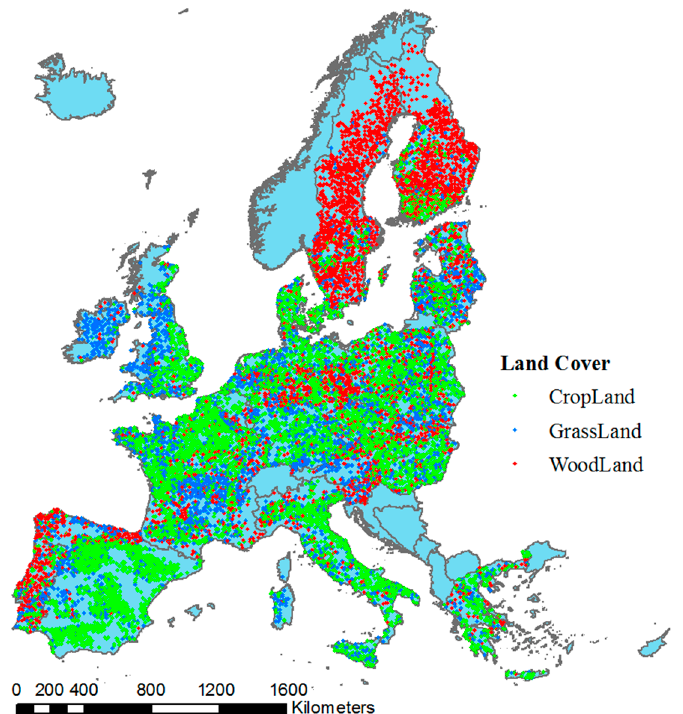
Figure 1. Location of selected soil samples from the Land Use/Land Cover Area Frame Survey (LUCAS) soil spectral library. The colour indicates the corresponding land cover type.